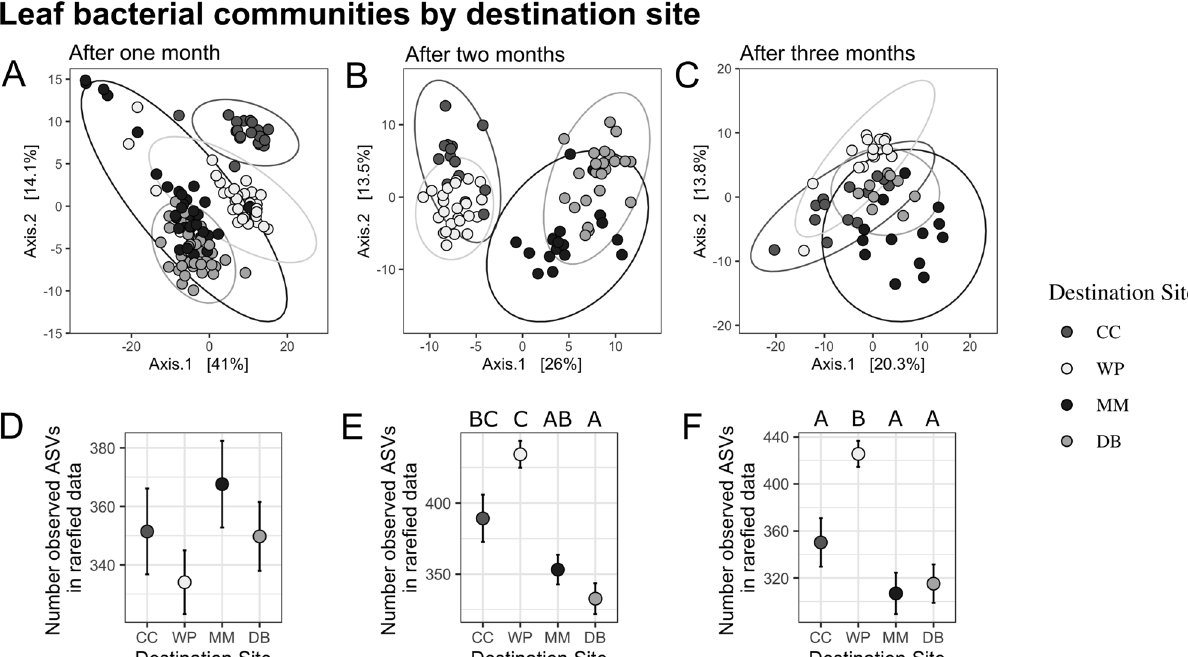
Figure 2. Differences in leaf microbial communities among destination sites. ( A – C ) Ordination of leaf bacterial community structure based on principal coordinate analysis of phylogenetic-isometric log-ratio transformed distances showing differences among sites by destination site ( A ) after one month, ( B ) after two months, and ( C ) after 3 months. All destination sites were distinct from others at all three timepoints (see Table 1). ( D – F ) Mean (+ /− 1 SE) amplicon sequence variant (ASV) richness on leaves at each site after 1, 2, and 3 months. Different letters above data points indicate significantly different ASV richness among destination